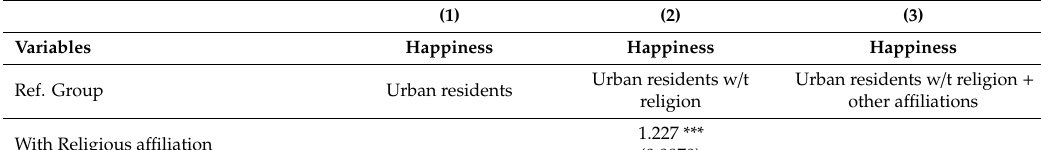
Table 2. Association between happiness and religion (basic model; ordered logistic model, odds ratio